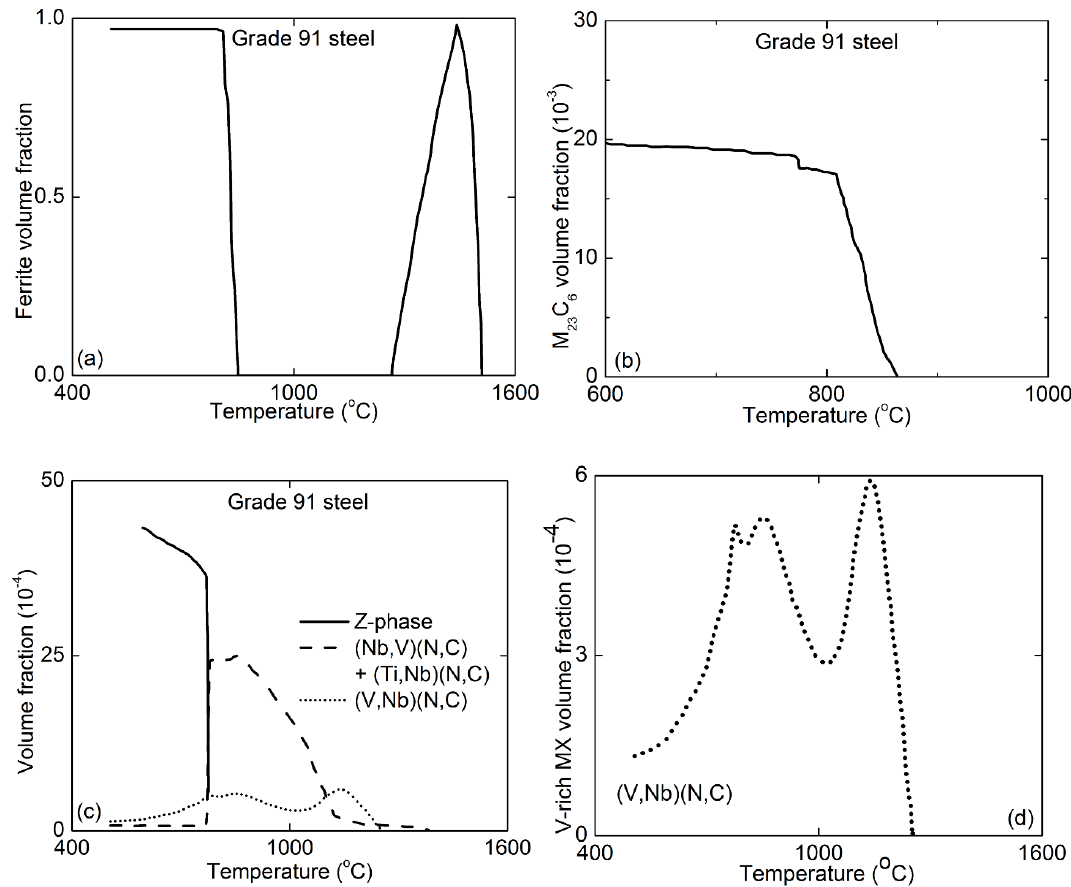
Figure 8. Evolutions of ( a ) the ferrite phase; ( b ) M 23 C 6 precipitate; ( c ) Z-phase, Nb-rich MX, V-rich MX, and Ti-rich MX precipitates; and ( d ) high resolution plot of (V,Nb)(N,C) precipitate as a function of